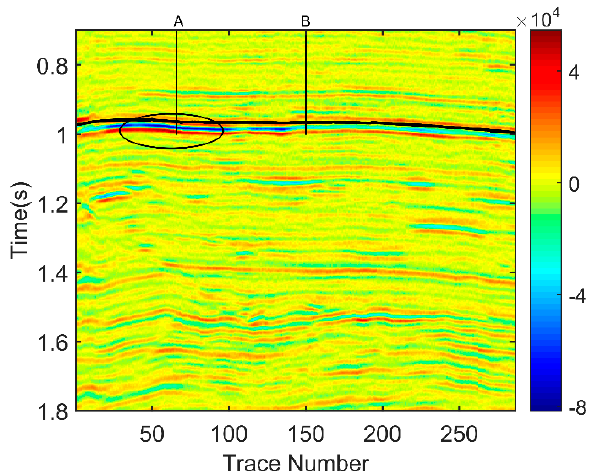
Figure 9. Field seismic data.